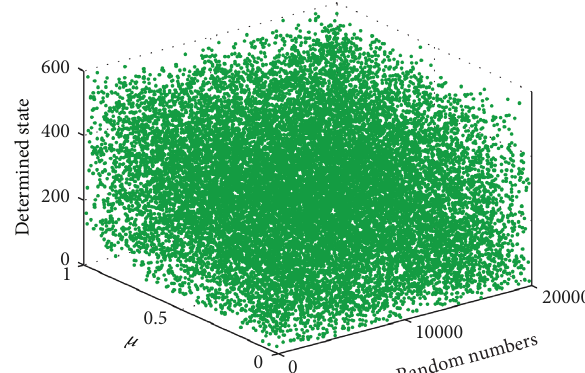
Figure 17: Monte Carlo simulation for the passengers.